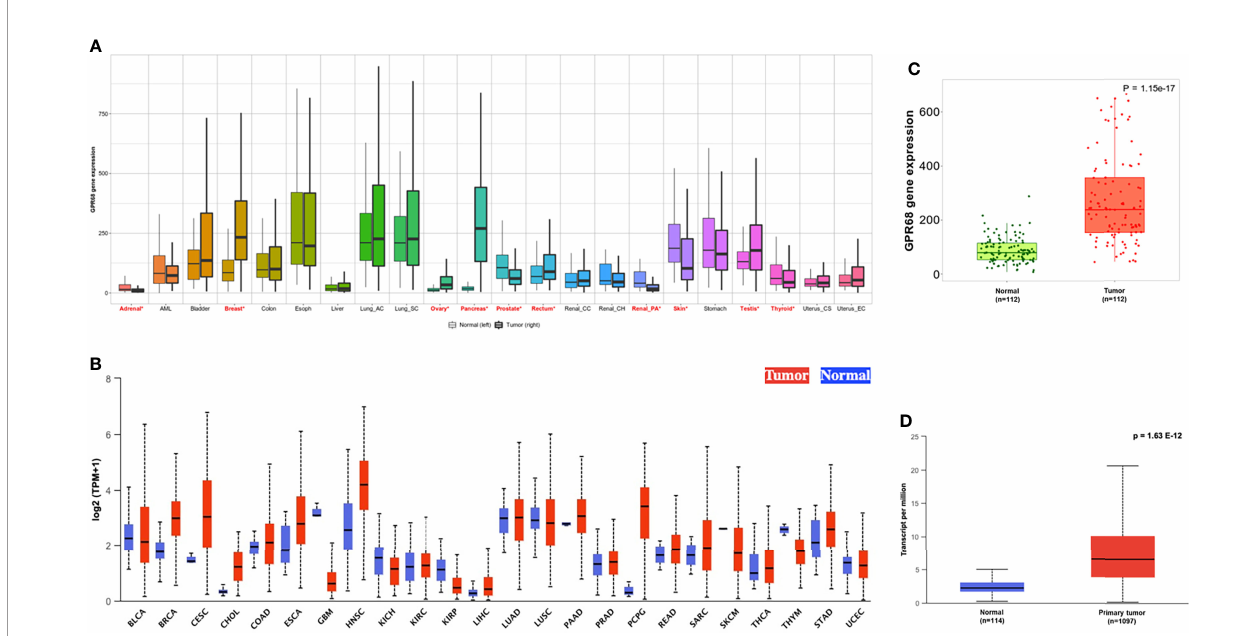
FIGURE 1 | In-silico expression of GPR68 across various cancer types. (A) TNMplot showing breast cancer to be among the cancers where GPR68 was upregulated in tumor tissues. The signi fi cant differences by the Mann-Whitney U test are marked with “ red* ” . (B) UALCAN tool supporting GPR68 upregulation in breast cancer. (C) GPR68 was upregulated in the breast cancer tissues (n=112) compared to paired adjacent normal breast tissues using TNMplot data analysis. (D) UALCAN tool con fi rmed the upregulation pattern in 1097 breast cancer patients compared to 114 normal breast tissues. BLCA, Bladder urothelial carcinoma; BRCA, Breast invasive carcinoma; CESC, Cervical squamous cell carcinoma and endocervical adenocarcinoma; CHOL, Cholangiocarcinoma; COAD, Colon adenocarcinoma; ESCA, Esophageal carcinoma; GBM, Glioblastoma multiforme; HNSC, Head and neck squamous cell carcinoma; KICH, Kidney chromophobe; KIRC, Kidney renal clear cell carcinoma; LIHC, Liver hepatocellular carcinoma; LUAD, Lung adenocarcinoma; LUSC, Lung squamous cell carcinoma; PAAD, Pancreatic adenocarcinoma; PCPG, Pheochromocytoma and paraganglioma; PRAD, Prostate adenocarcinoma; READ, Rectum adenocarcinoma; SARC, Sarcoma; SKCM, Skin cutaneous melanoma; STAD, Stomach adenocarcinoma; THCA, Thyroid carcinoma; THYM, Thymoma; UCEC , Uterine corpus endometrial